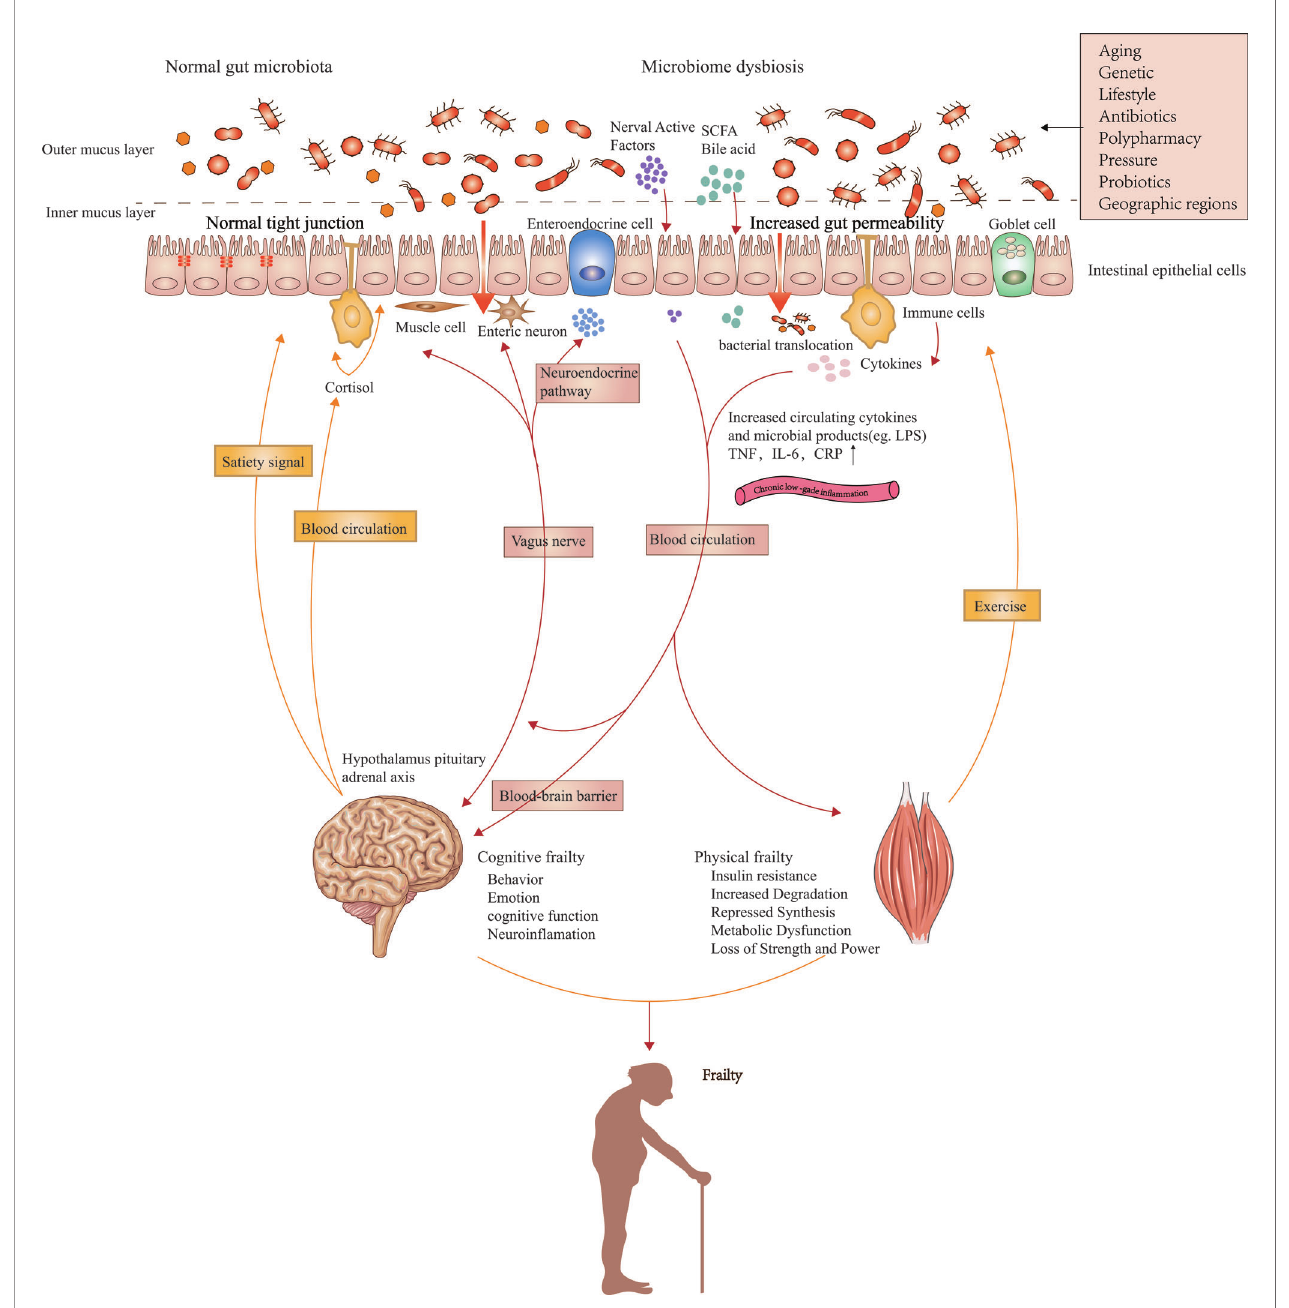
FIGURE 1 | Possible mechanisms linking gut microbiota composition, chronic low-grade in fl ammation, and frailty. Impairments in the intestinal barrier caused by aged gut microbiota can promote the penetration and systemic dissemination of microbiota and its metabolites, which then leads to chronic low-grade in fl ammation by promoting the expression of proin fl ammatory factors. Metabolites from commensal microbiota as well as peripheral in fl ammation affect protein breakdown and synthesis in the muscle via multiple signaling pathways that result from in fl ammation and insulin sensitivity. The effects of muscles on gut microbiota are mainly realized by exercise. The brain controls the composition of gut microbiota by in fl uencing peptides regulating satiety signals, intestinal function, and the secretion of neural chemicals. Intestinal dysbacteriosis affects in fl ammation and neurodegeneration in the central nervous system via immune, vagal, and neuroendocrine pathways, which ultimately lead to impaired cognitive function. Gut microbiota can also indirectly cause the onset of sarcopenia and physical frailty by affecting food